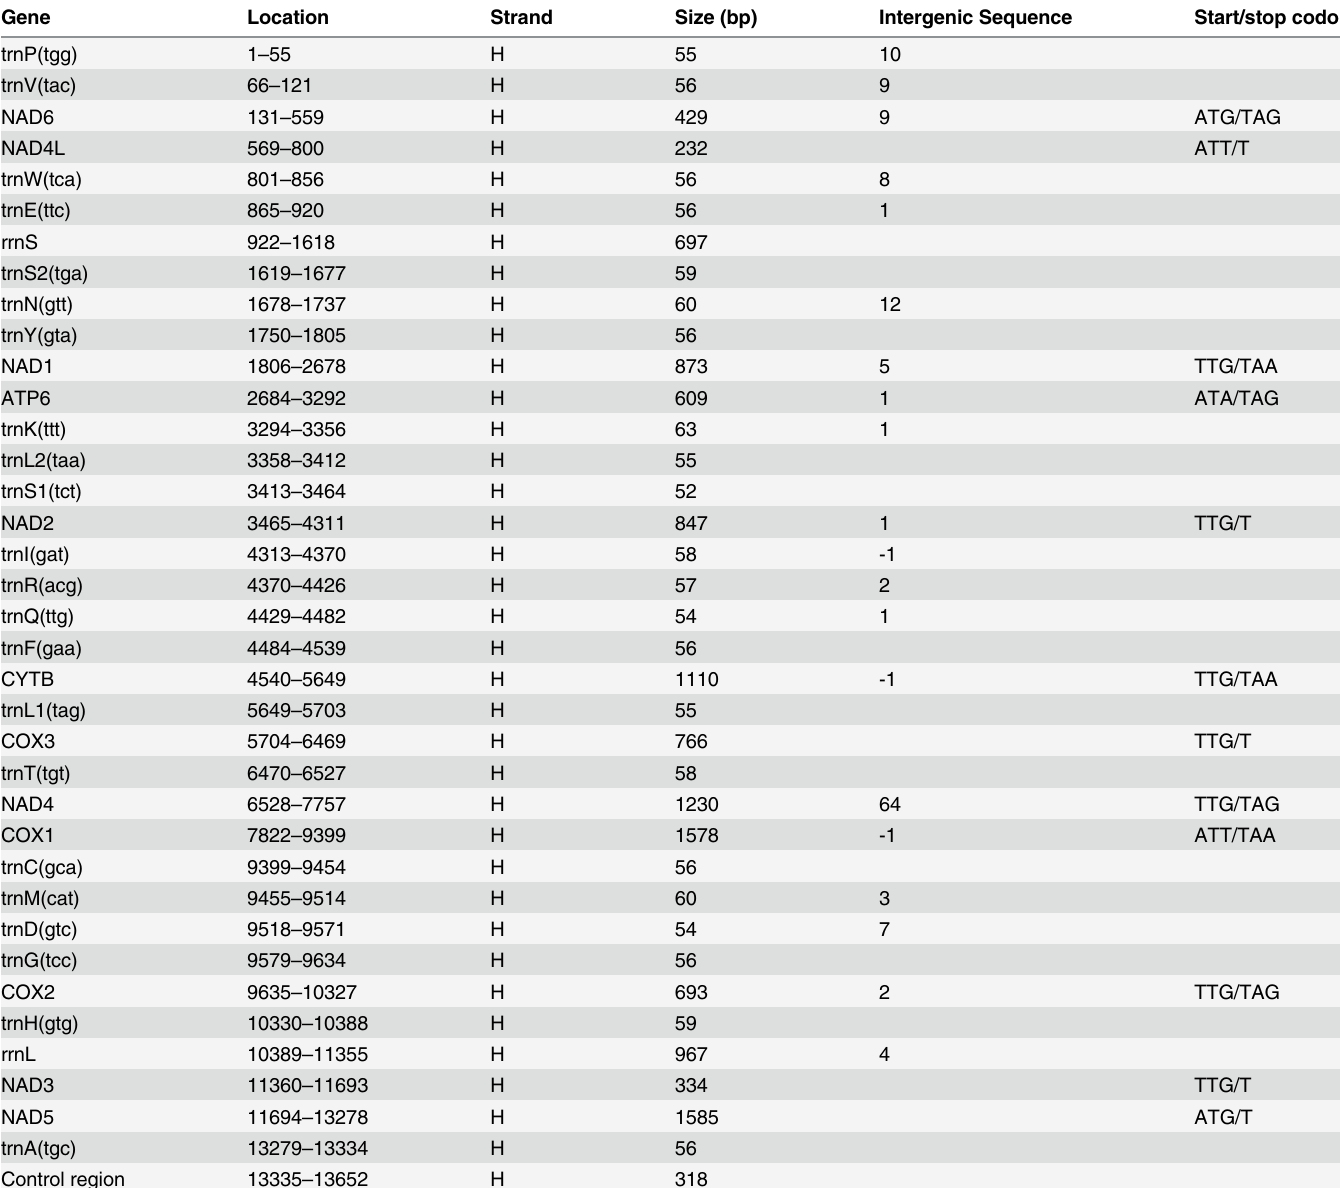
Table 2. Gene order of mitochondrial genome of Angiostrongylus costaricensis (Costa Rica taxon). Gene Location Strand Size (bp) Intergenic Sequence Start/stop